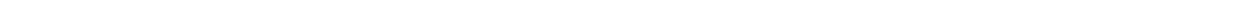
Fig. 6 DDR signaling impairment in FUS-NLS mutations is upstream of neurodegeneration and aggregation formation. a Mutant P525L FUS failed to be recruited to DNA damage sites. Recruitment-withdrawal to Laser cuts in MN nuclei (boxed area) expressing normal (WT) or mutant P525L (Mut) FUS- GFP was imaged live at 21 DIV (Supplementary Movie 6). b Quanti fi cation of a , FUS-GFP at cut over time. c Chemical modulation of nuclear FUS impacted on recruitment of FUS-GFP to cuts in WT cells (top gallery) treated 24 h mock, with PARP1 inhib., etoposide or arsenite or in mutant cells (bottom gallery) treated 24 h mock, with PARG, DNA-PK inhibitors or AdOx (Supplementary Movie 6). d Quanti fi cation of c . e Compounds impacted on nuclear FUS-GFP levels in MNs: treatments WT versus Mut as for c , bars: 10 µ m. f Quanti fi cation of e , ratio FUS-GFP amount nucleus/cytosol (left) or total FUS amount in cytoplasmic aggregates (right). Data are plotted as mean, error bars = STDEV, one-way ANOVA with post-hoc Bonferroni test (*, **, ***P values of 0.05, 0.01, and 0.001, respectively, N = 3). g Proximal compound addition impacted on distal axonal traf fi cking at 21 DIV depicted as maximum intensity projections: PAPR1 inhib. mimicked mtFUS-phenotype whereas PARG, DNA-PK inibitors and AdOx rescued mtFUS phenotype (Supplementary Movies 8, 9). Shown are representative examples of Ctrl1 and R521L, see Table 1. h – l Organelle tracking ( h , i ), mitochondrial membrane potential ( j ) and shape ( k , l ) analyses of G as box plots, batch analysis of Ctrl1-3 (Ctrl: Mock, PARP1 inhib.) and FUS R521C, R521L, R495QfsX527 (FUS: PARG inhib.) as described in Table 1, exception: DNA-PK and AdOx inhib. only on FUS R521L. m Left column: impact of microtubule disruption (24 h nocodazole, 5 µ M, mid) or respiratory inhibition (24 h oligomycin A, 10 µ M, bottom) on the recruitment of WT FUS-GFP to the Laser cut in nuclei (boxed areas) in uncompartmentalized MN at 21 DIV (Supplementary Movie 10). Note the unaltered FUS recruitment (green) despite the severe disruption of the mitochondria network (mitotracker deep red FM, LUT red hot) along with loss of processive motility in the treated cells (maximum intensity projection of movies). Mid and right column: ditto for treatment exclusively at the distal exit site of 900 µ m-MFCs (Supplementary Movie 11). Note the unaltered FUS recruitment (proximal entry, boxed areas) despite the severe disruption of the mitochondria network along with loss of processive motility at the distal